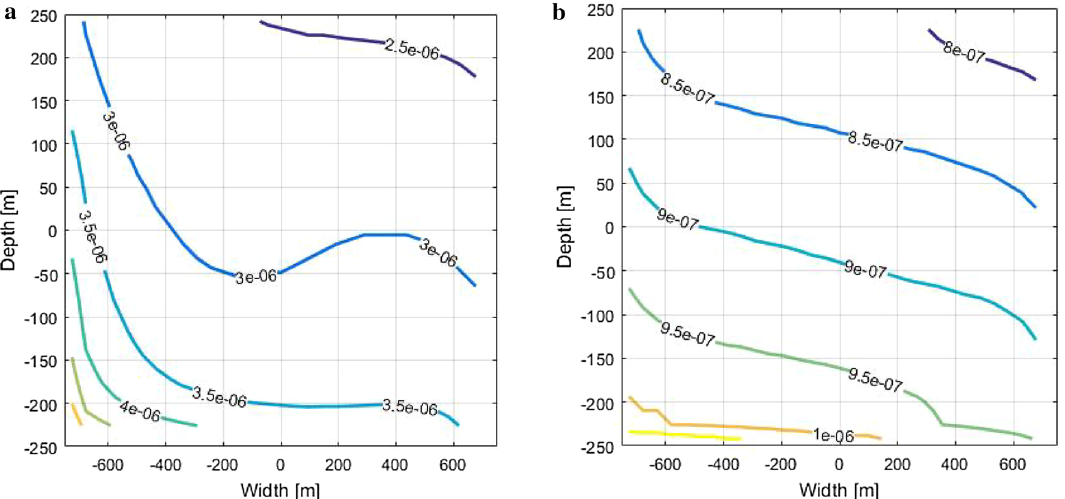
Fig. 13 a Contour plot of bulk velocity (m/s), with natural convection, k = 1 md, gas condensate. b Contour plot of bulk velocity (m/s), with natural convection, k = 1 md, volatile